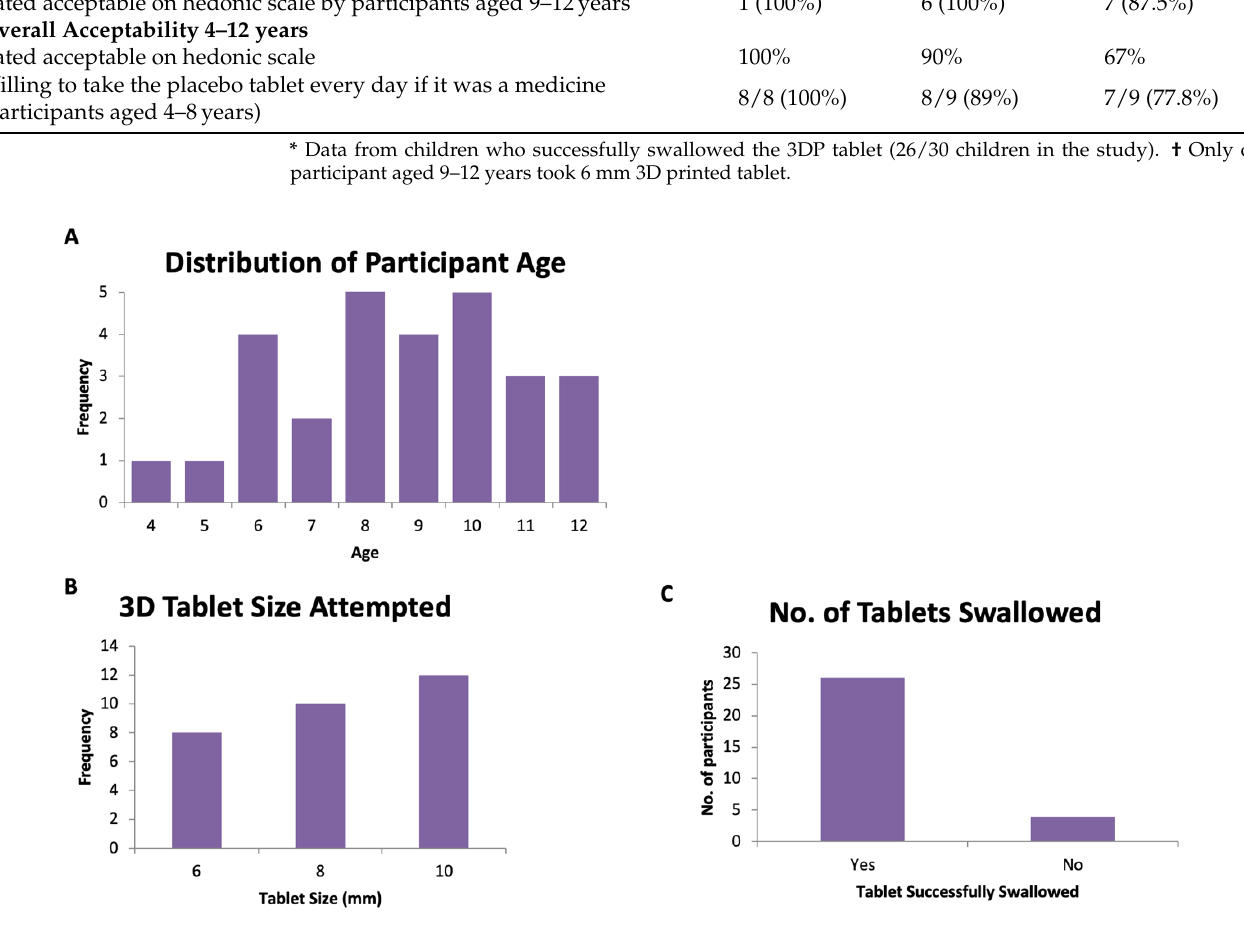
Figure 4. ( A ) Distribution of participants’ age, ( B ) the number of participants versus tablet size, and ( C ) the overall number of tablets swallowed.